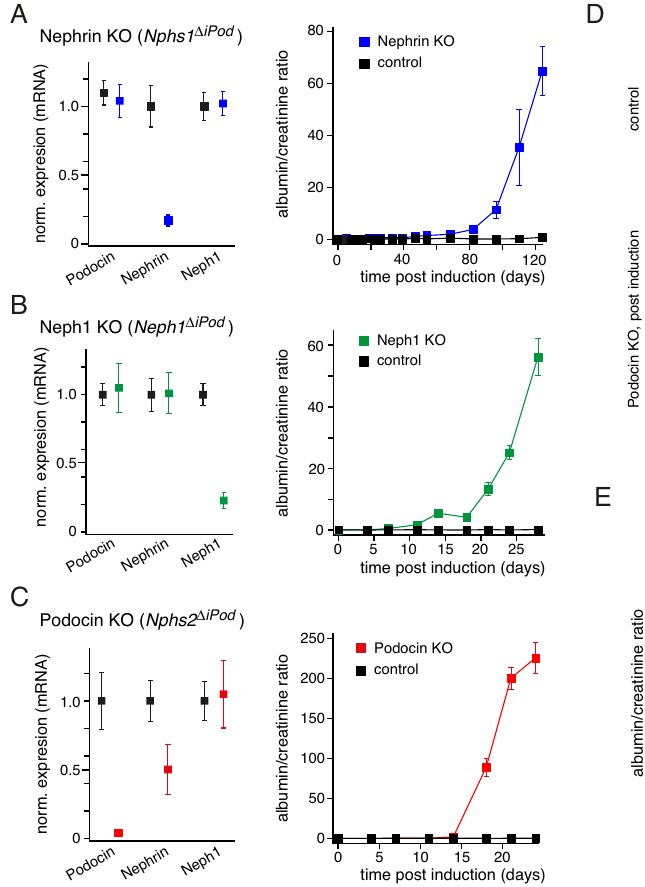
Fig. 3 | Distinct time-courses of protein stability and development of albuminuria observed after induced knockout of SD core-constituents. A – C QuantitativeanalysisofmRNAscodingforNephrin,Neph1,andPodocinthree weeks after induction of the target-gene knockout (left panel) and of the albumin/ creatinine ratio determined post-induction (right panel) in control and knockout animals. Data are mean (±SEM) of 5 (WT, Nephrin KO), 4 (WT, Neph1 KO), 7 (WT, PodocinKO)(mRNA),and10,10,9,and6WT,NephrinKO,Neph1KO,andPodocin KO animals (albumin/creatinine ratio), respectively. D Immuno fl uorescence was